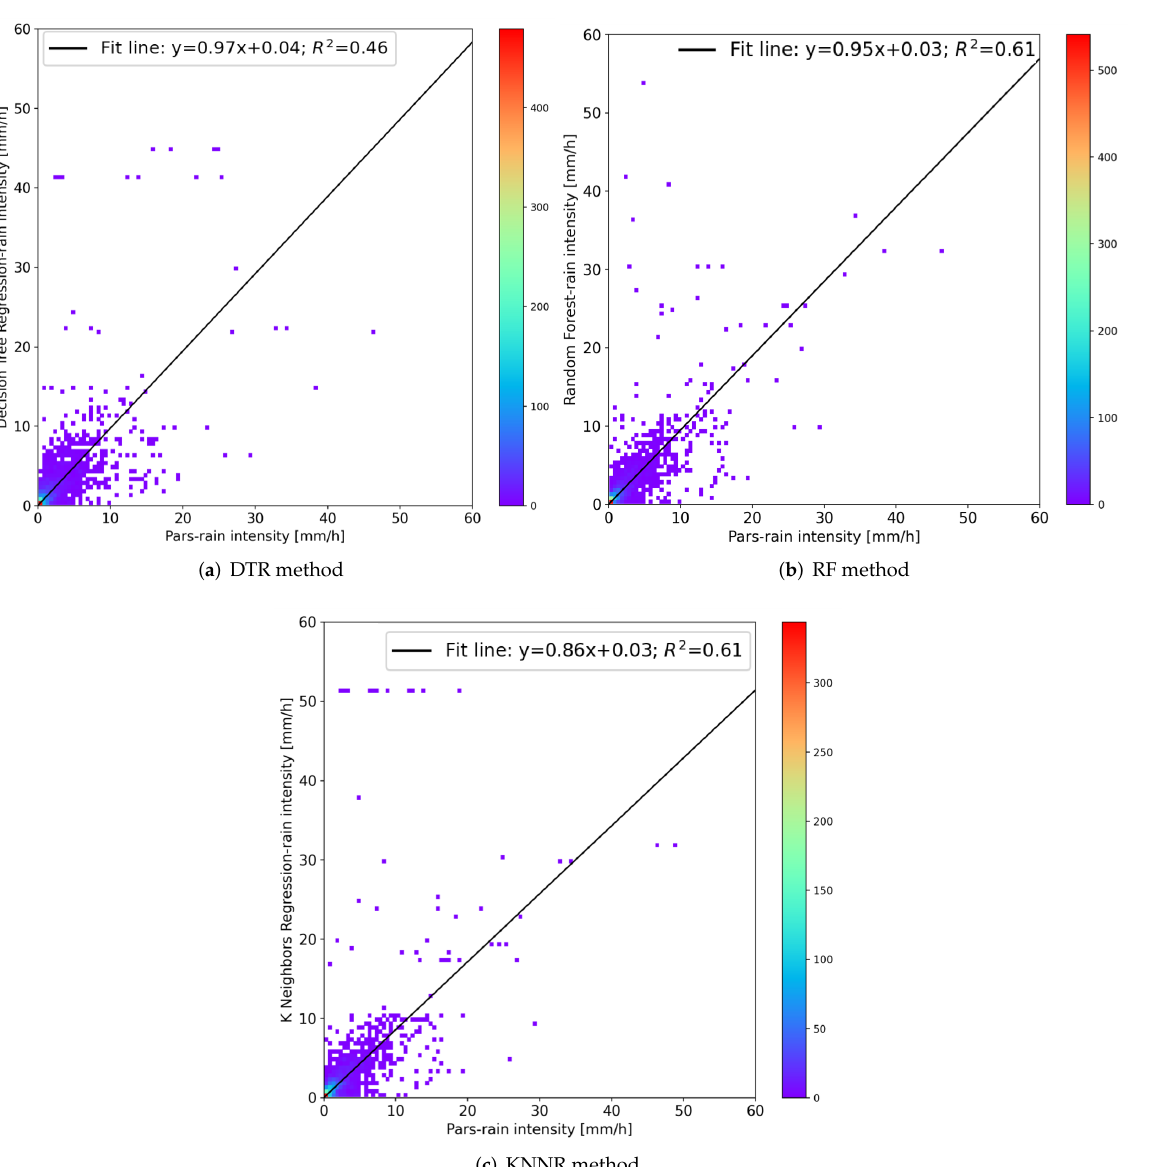
Figure 9. Comparison of the 1-min rainfall intensities estimated by the PRS with the reference laser disdrometer for all the two-month period (May and July).